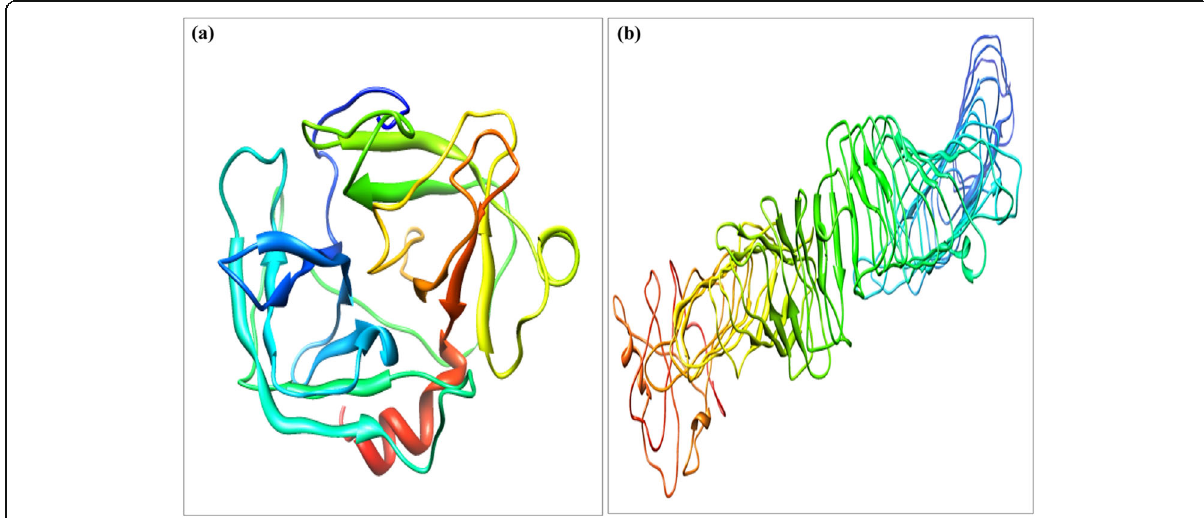
Fig. 3 Predicted 3D structure of cocoonse and sericin. a Cocoonase with C-score 1.19 showing the model of correct global topology, and b sericin with C-score − 0.53 and C-score > − 1.5 indicating a model of correct global topology. The models are colored based on rainbow coloring scheme with N-terminal of protein colored blue and C-terminal colored red. For cocoonase and sericin, the helical structures in red color represent α -helix, 3 10 - helical structures in blue color, and arrow in yellow color represent β -sheets; turns were represented in cyan, and coils were in purple